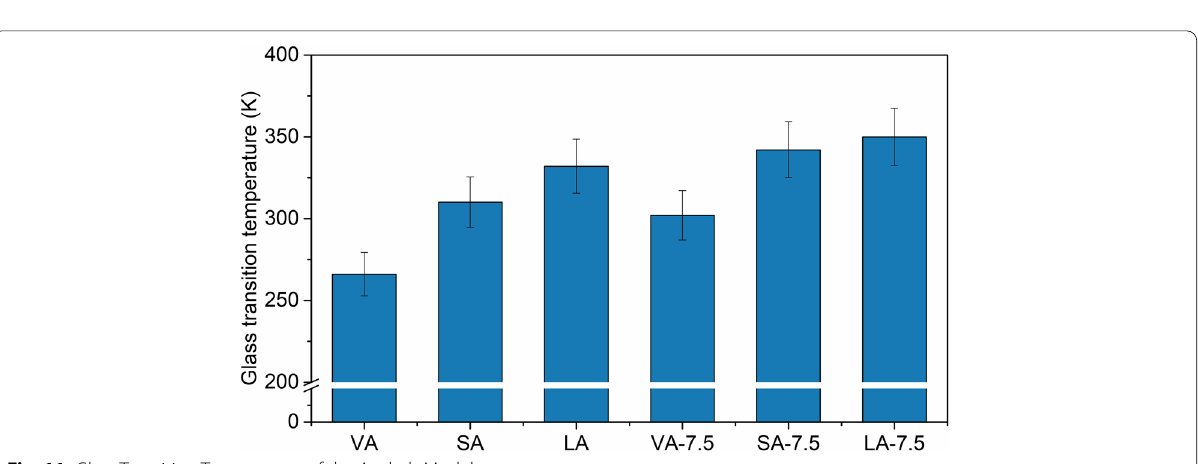
the asphalt model showed a bimodal distribution. The relative concentration at the middle and the edges were both 0.0, indicating that the asphalt has not started to heal. From 200 ps to 400 ps, the relative concentration of the two peaks decreased significantly. The relative concentration of the middle valley began to increase, and the crack width gradually decreased, indicating that the asphalt molecules began to diffuse toward the mid- dle crack. From 600 ps to 1000 ps, both peaks and valleys disappear, and the relative concentration approaches 1.0, the molecules on both sides of the crack come into con- tact, and the asphalt molecular model begins to heal. This finding is consistent with changes in density. As shown in Fig. 15, the relative concentration values were close to 0 in the nano-crack area of the z -direction before healing. As the temperature rises, the two peaks